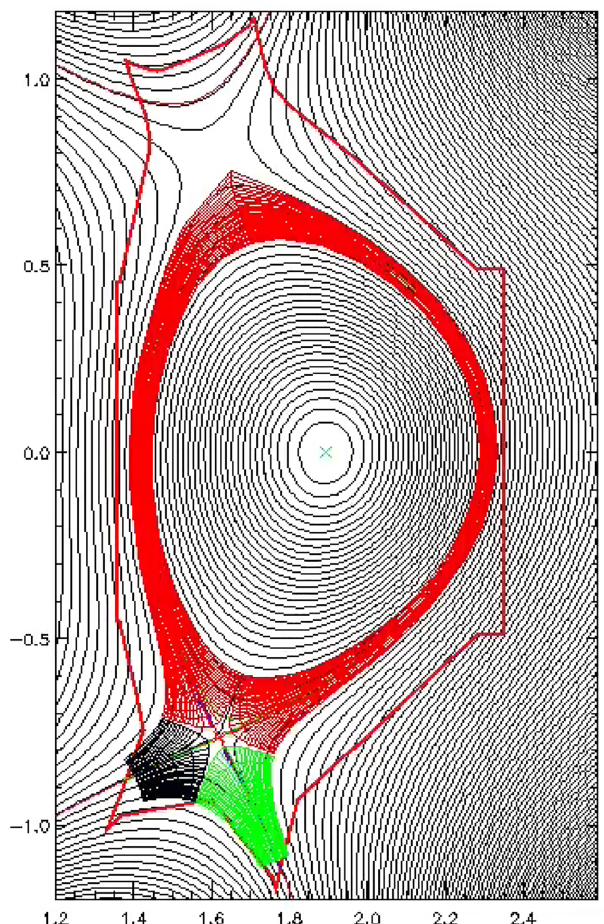
Figure 1. The grid image of BTC simulation for EAST shot #48,337 with a resolution of 36 × 64 (radial × poloidal).